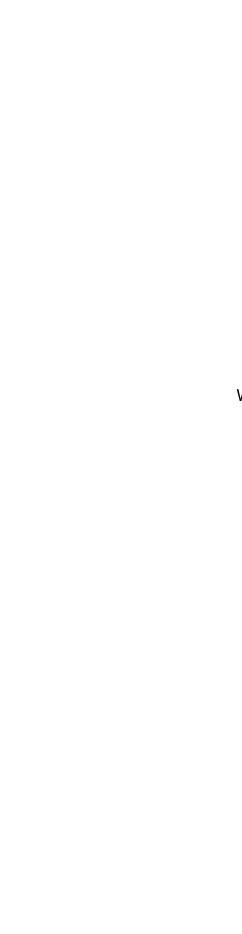
Figure 10. Mutation screening by denaturing high performance liquid chromatography (dHPLC) using WAVE TM , Transgenomics. dHPLC can be used as an initial mutation screening method, being dependent on heteroduplex (wild type-mutant) formation, and variant profiles from the wild pattern are subsequently sequenced. Note however, that dHPLC is not capable of detecting